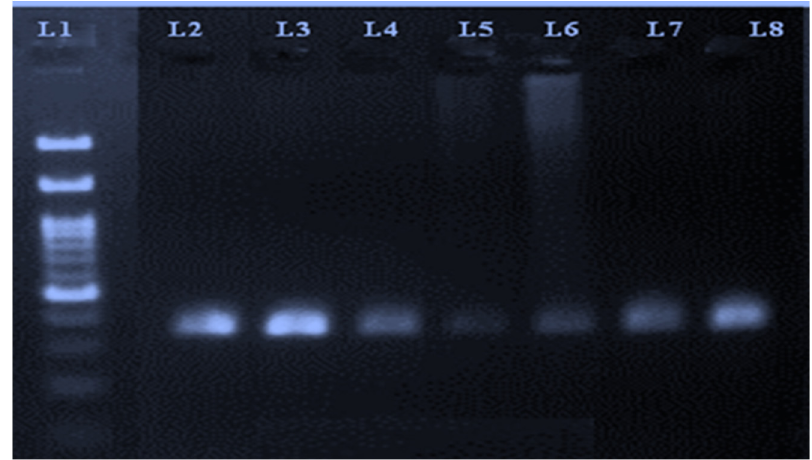
Figure 1. PCR amplicons of reference gene (transferrin) run on 2% agarose gel. Lane 1 represents a 100 bp ladder, whereas Lanes 2 to 8 correspond to PCR amplicon products. Table 4. Query sequences producing significant alignments with the top 10 species.